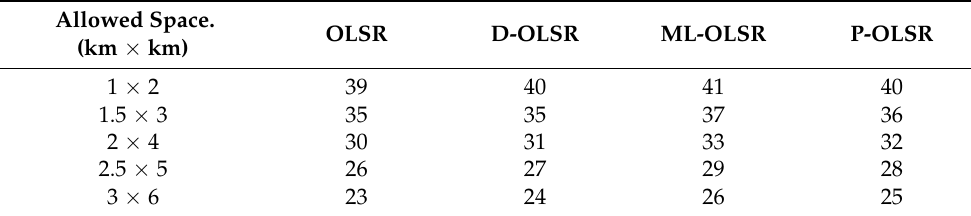
Figure 16. Energy consumption vs. allowed space. Table 4. A comparison of the total number of data packets sent by four routing protocols during the allowed space scenario.